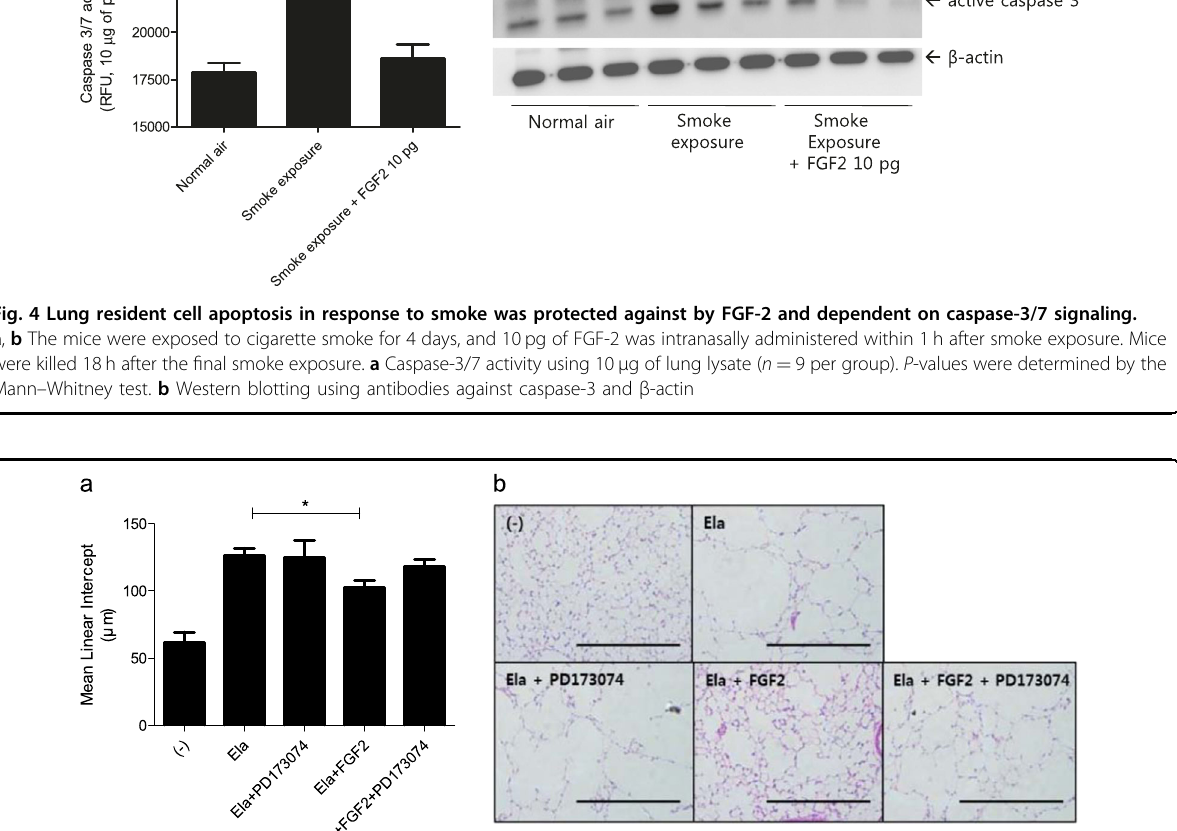
from patients with COPD and normal controls using ELISA in 10 subjects each from the study groups. Plasma